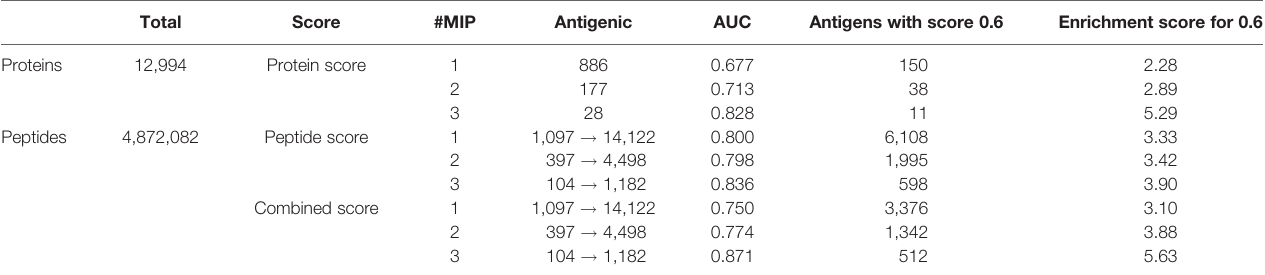
TABLE 7 | Performance of APRANK on Onchocerca volvulus